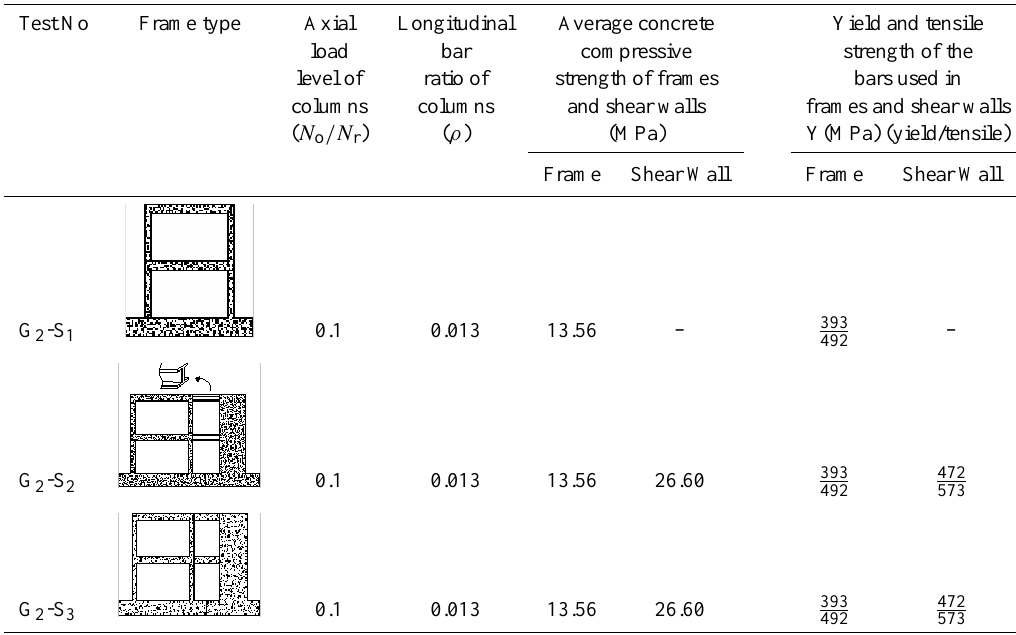
Table 2. Characteristics of the specimens in the 2 nd test program Average